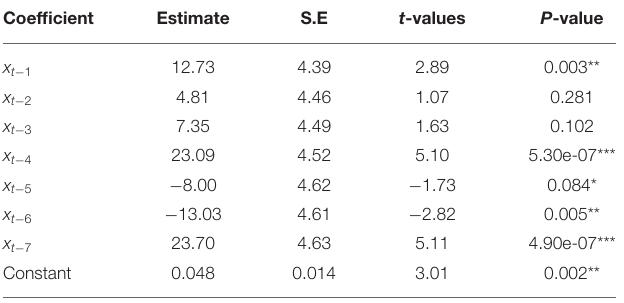
FIGURE 5 | Inverse roots. TABLE 4 | VAR model estimates. Coefficient Estimate